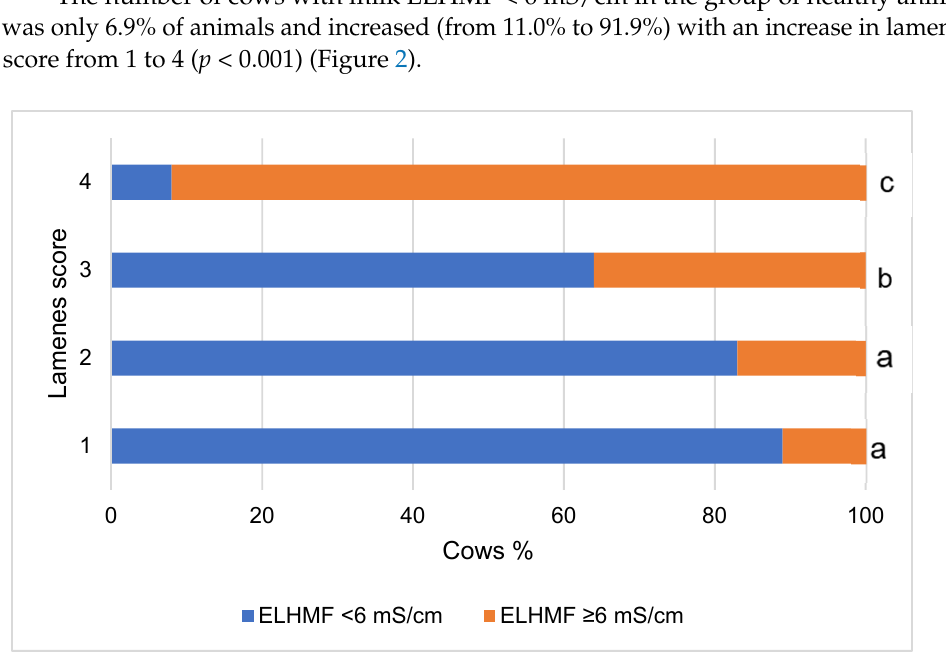
Figure 2. Relationship of lameness intensity with ELHMF level. ELHMF—Electrical conductivity at the maximum milk flow. a, b, c —different letters indicate that the difference in the frequencies of the ELHMF groups in terms of lameness score is statistically significant ( p < 0.05).